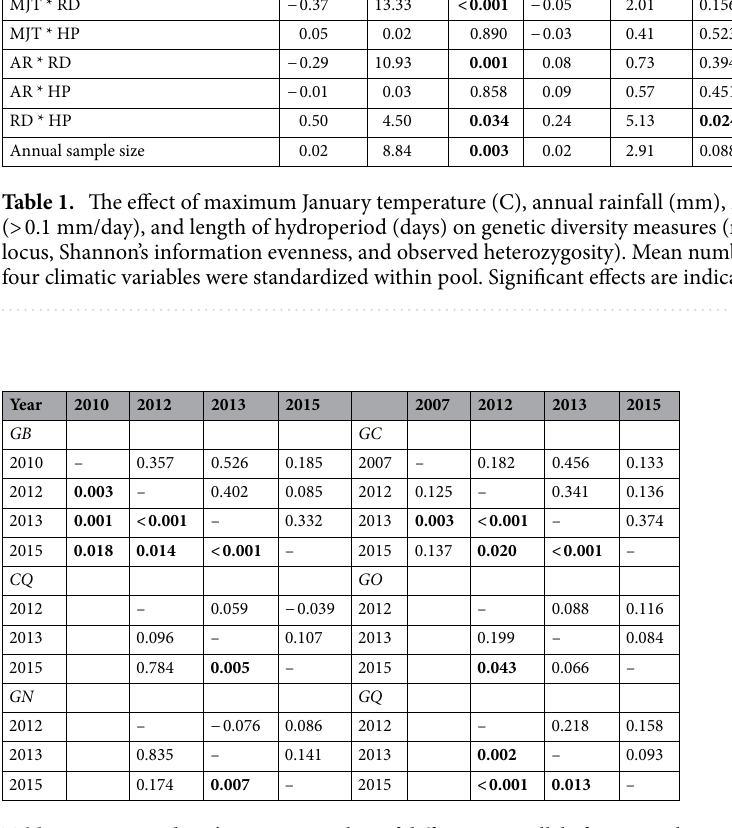
Table 2. Corrected Nei’s average number of differences in allele frequency between years within each pool (D A ; above diagonal), and the associated P value (below diagonal). Significant D A distances are indicated in bold. Pool name abbreviations were taken from Table